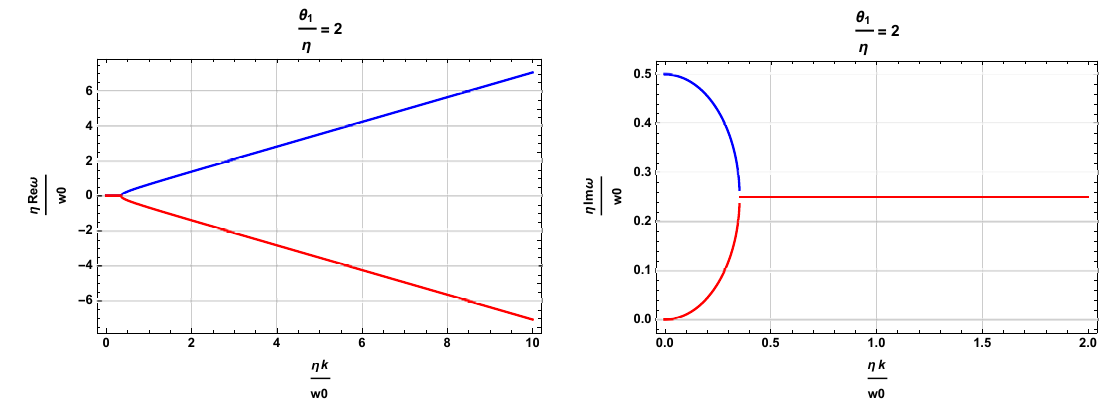
= 2. Left figure η